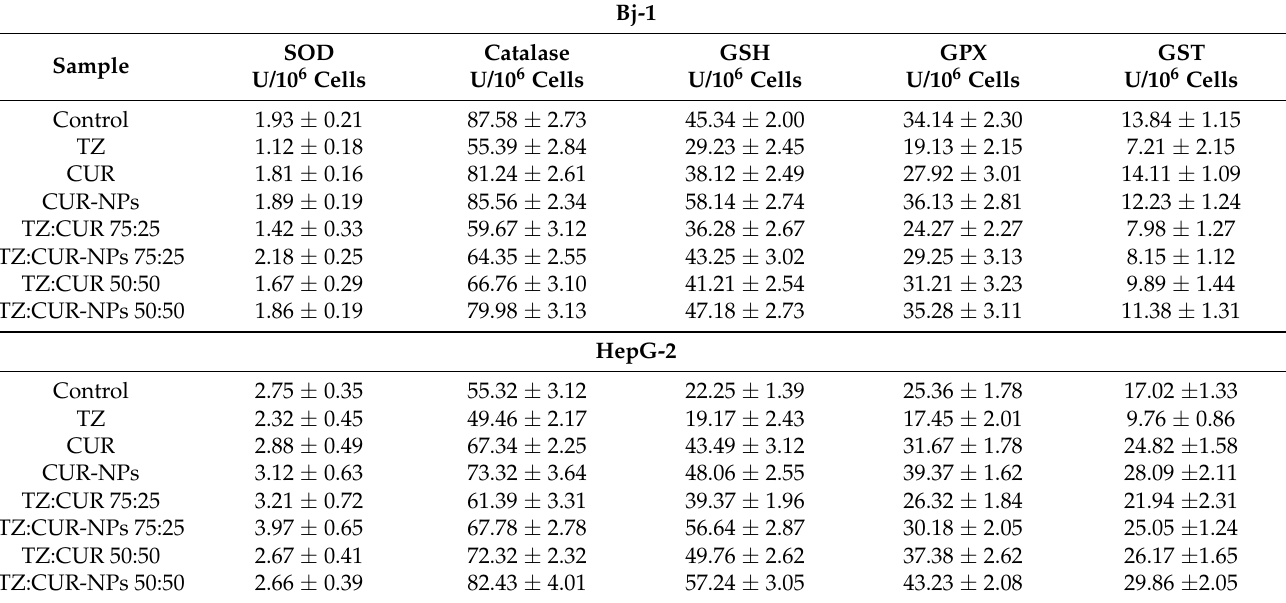
Table 3. Oxidative stress enzymes activity in Bj-1 and HepG-2 treated cells. Bj-1